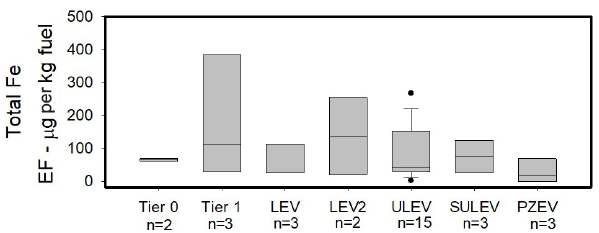
Figure 1. Total iron from the 32 vehicles tested reported in EF (µg per kg fuel). The center black line represents the median value and the edges of the boxes represent the 25th and 75th percentiles, while the whiskers extent are the 10th and 90th